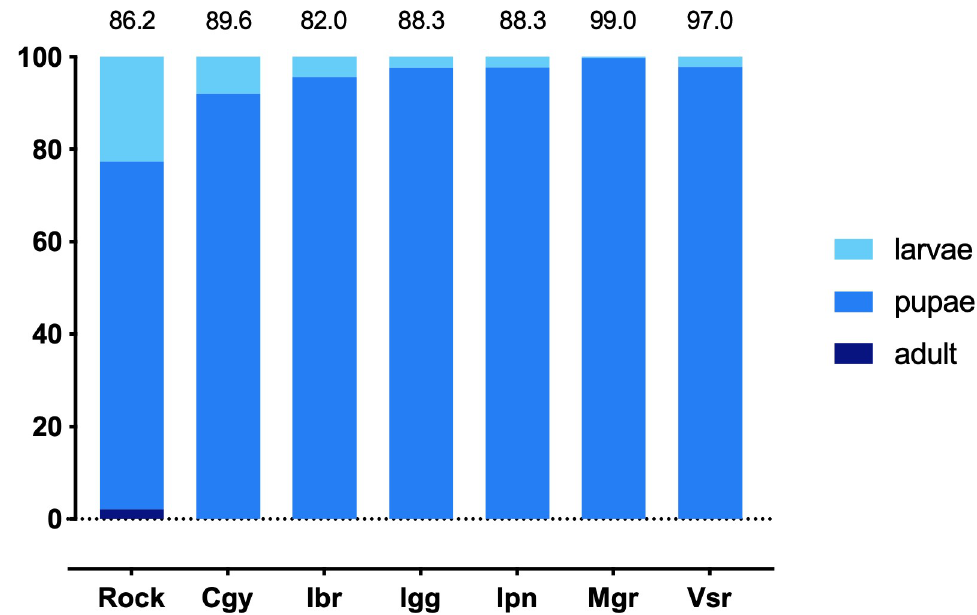
Fig 3. Proportional life-stage mortality of larvae of Aedes aegypti populations from Rio de Janeiro exposed to pyriproxyfen for 7–10 days. Adults’ emergence was 100% inhibited in the reference lineage Rockefeller (Rock) and all populations. Values over the bars indicate the mortality percentage at the end of the test (when 100% of the control condition larvae emerged into adults).